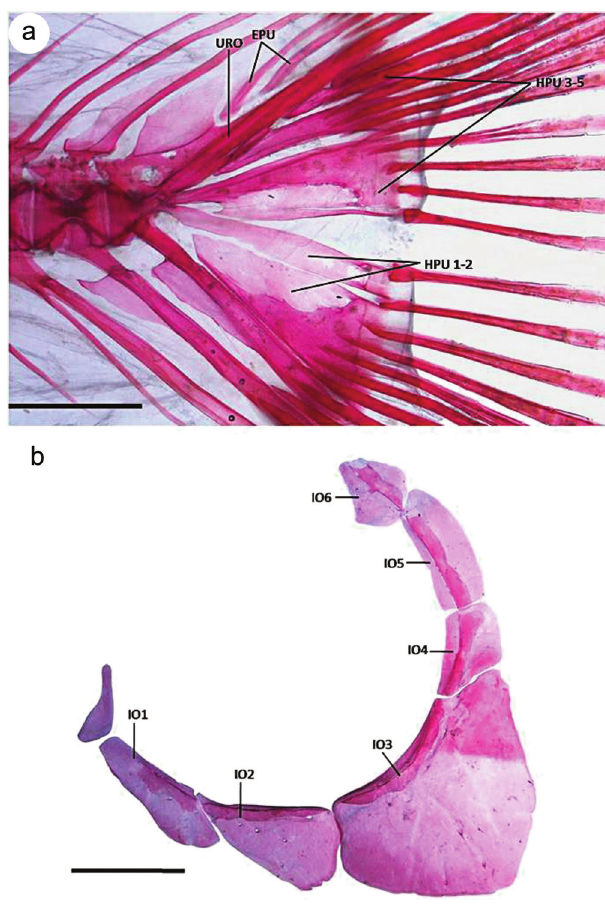
Fig. 6. Probolodus oyakawai : a) caudal skeleton, MZUSP 55006, paratype, 36.8 mm SL, lateral view. EPU: epurals, HPU 1-5: hypurals, URO: urostyle; b) infraorbital series, MZUSP 53499, paratype, 64.3 mm SL, lateral view. IO 1-6: first to sixth infraorbitals. Scale bars = 1